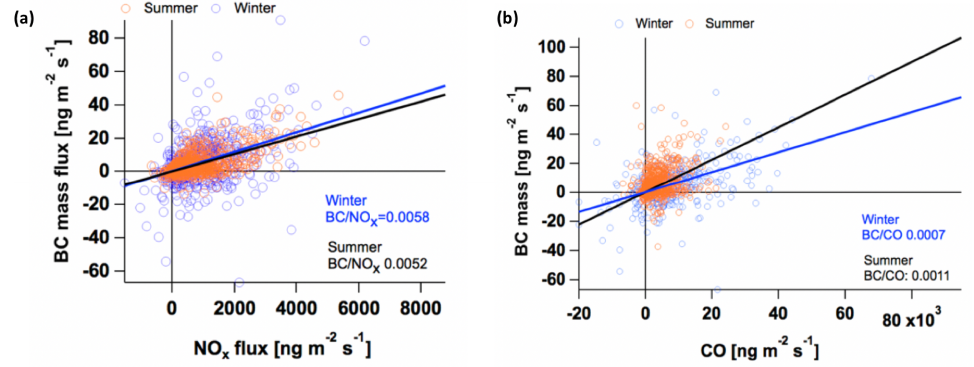
Figure 10. BC mass flux with (a) NO x flux (Squires et al., 2020) and (b) CO flux (Squires et al., 2020) for winter and summer with calculated BC / NO x and BC / CO ratios and NO x and CO fluxes converted to the same units as our